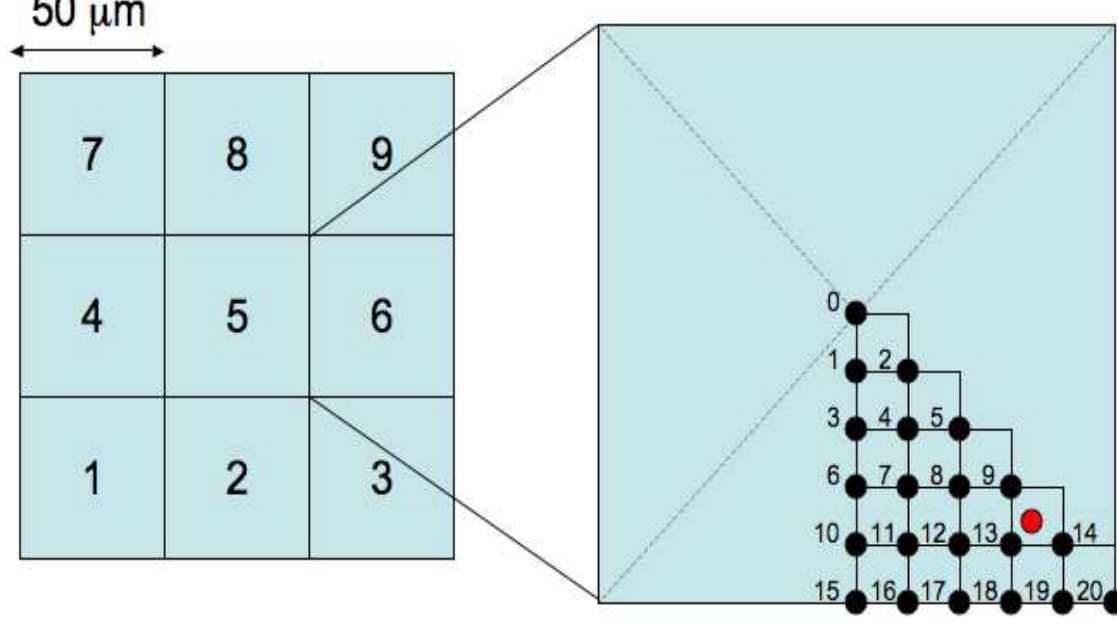
Figure 7. The geometry used in the TCAD simulation. The red circle indicates the position of the charge collecting diode in the lower right